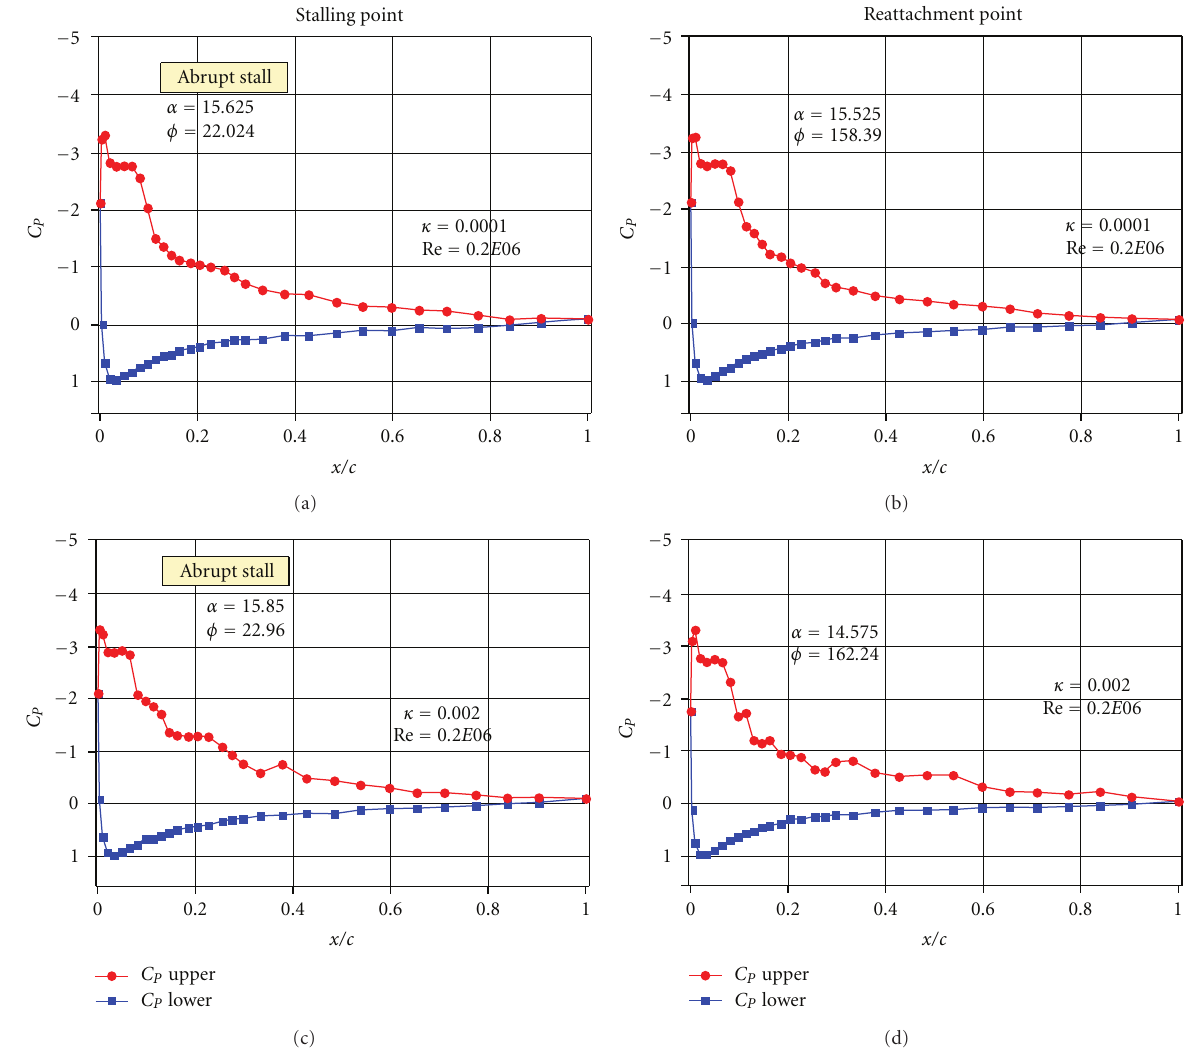
Figure 12: C P Distribution plot at stalling and reattachment points for κ = 0 . 0001 and 0.002 at constant Re = 0 . 2 E 06. method adapted for the boundary layer solution of the Navier-Stokes equation